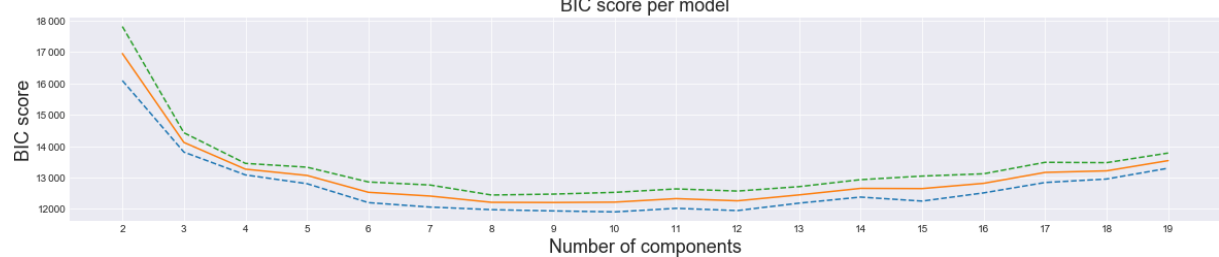
Figure 1. BIC score versus the specified number of classes K for UKESM1 data. The solid line is the mean BIC value, and the dashed lines represent 1 standard deviation on either side of the